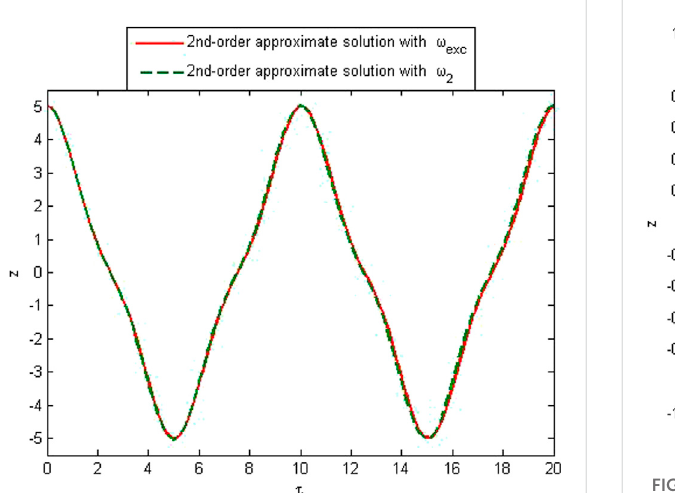
FIGURE 6 Graphing solution (28) for sequences of the parameter φ with A (cid:2)